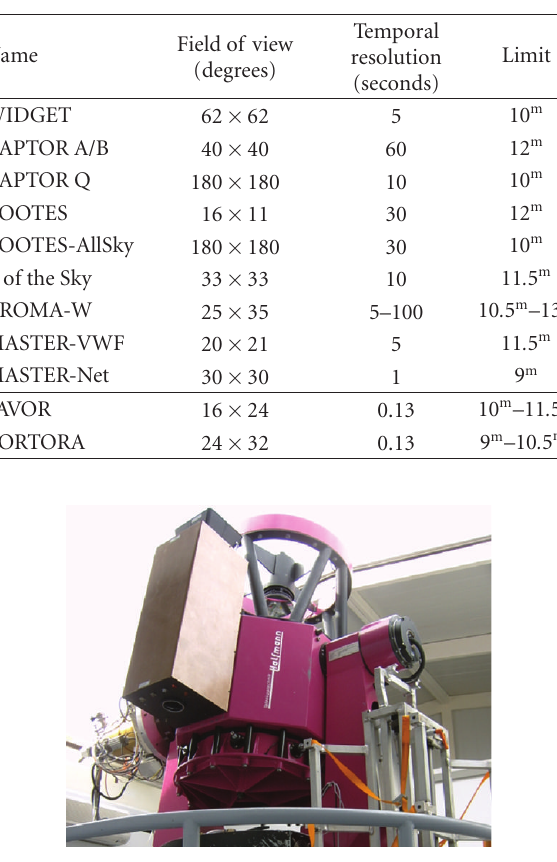
Table 1: Typical wide-field monitoring cameras currently in operation. For FAVOR and TORTORA the limits correspond to 3 σ detection on a single frame and di ff er from their real-time operational values.